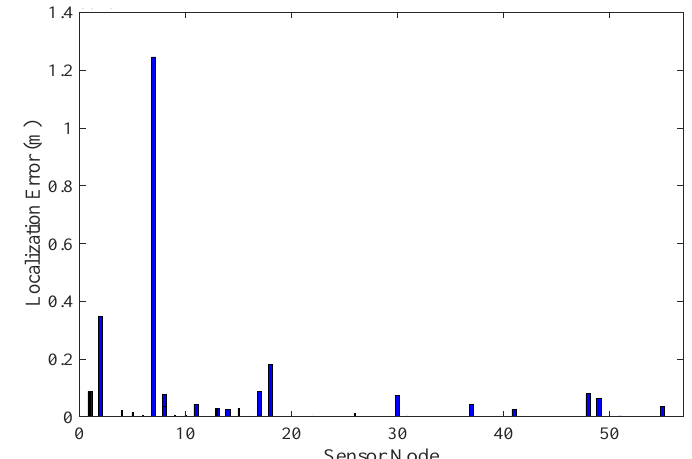
Figure 7. Estimated location of anchor, actual and estimated sensor nodes in 3D environment with V = 100 and N = 160.